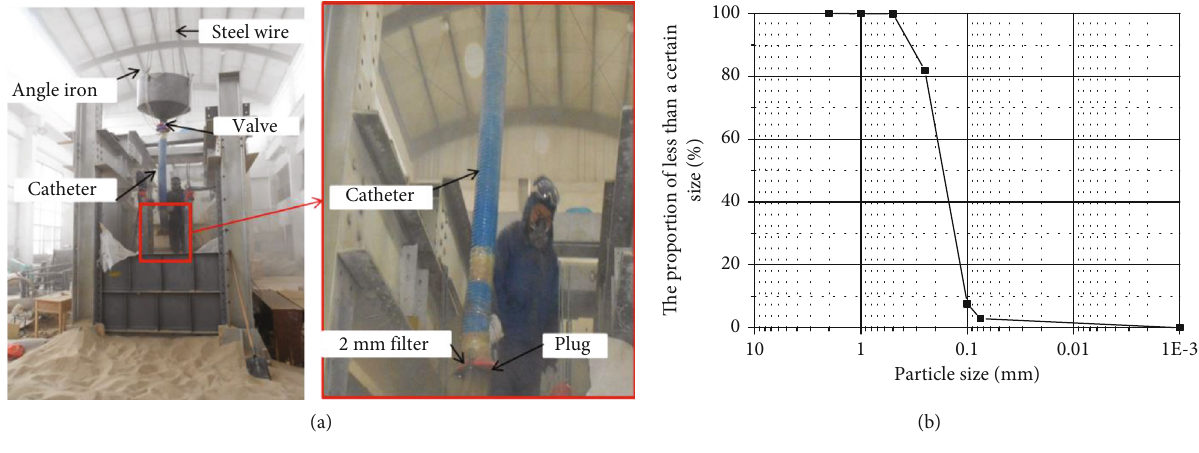
Figure 4: Sand fi lling: (a) sand pourer; (b) sand gradation